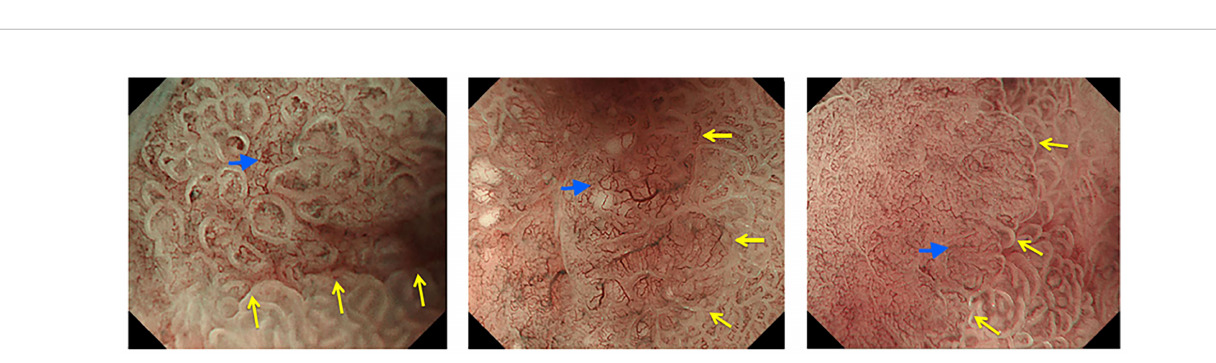
FIGURE 3 | Demarcation line (yellow arrows) and irregular microvascular pattern (blue arrows) suggesting early gastric cancer. Reproduced with permission from Muto M et al. (19)